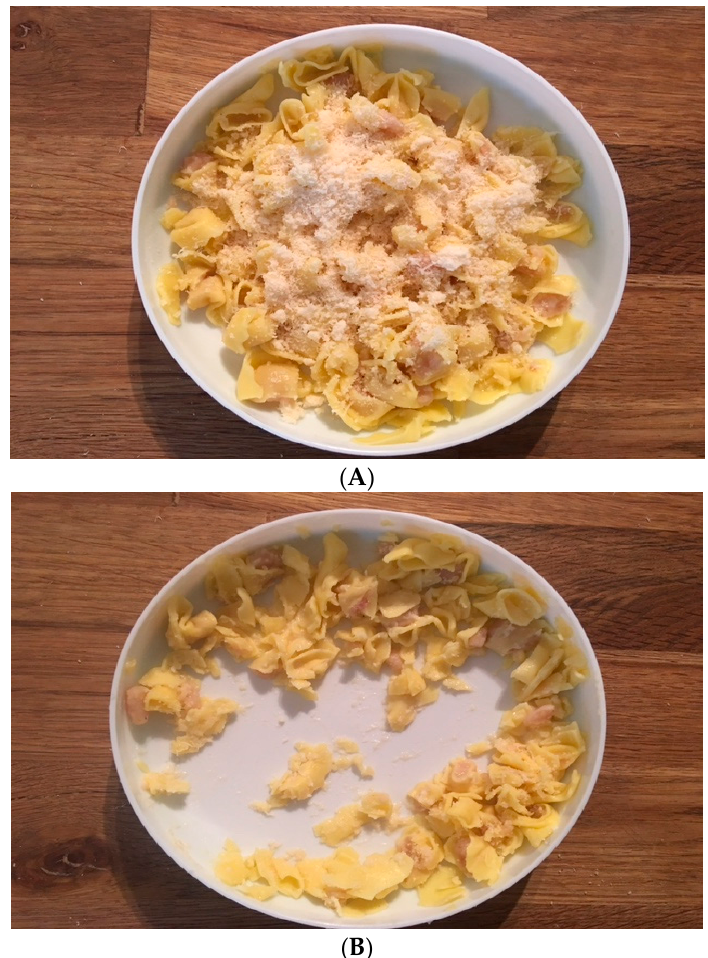
Figure 1. Images of a main course meal with leftovers before ( A ) and after ( B ) an eating session.